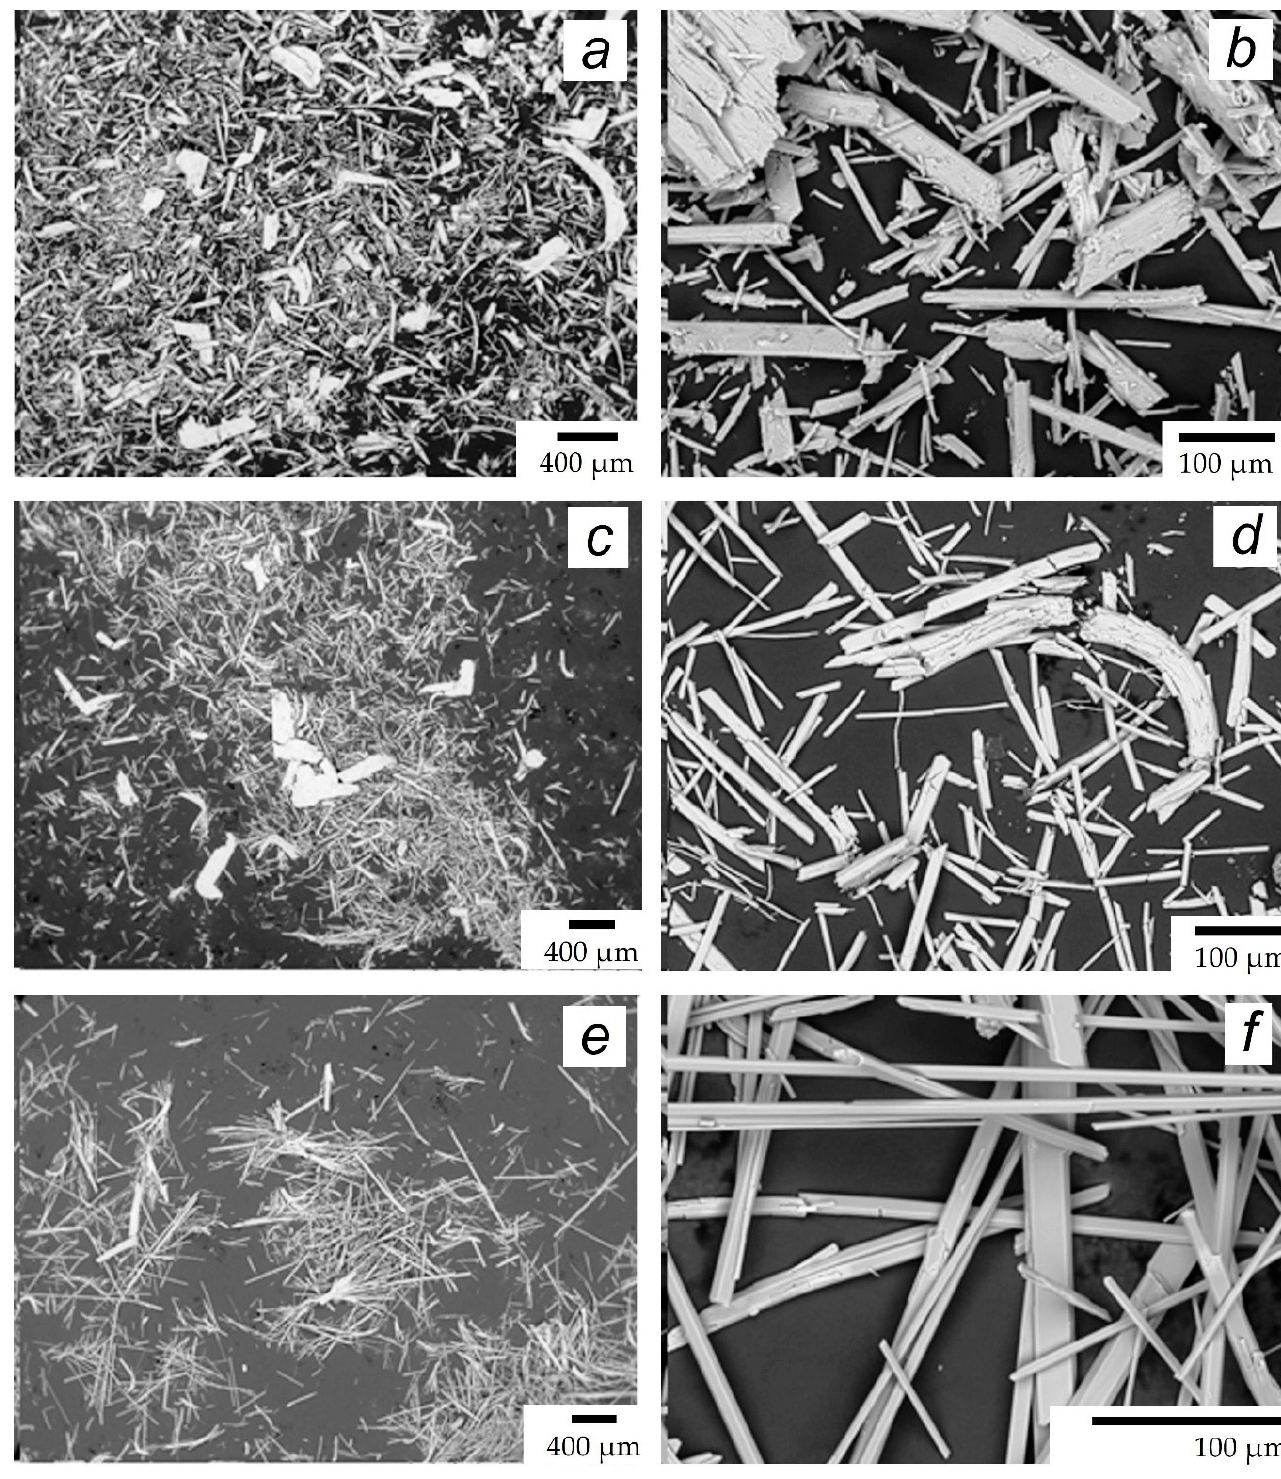
Figure 2. SEM images of calcium sulfate crystals, isolated from I ( a , b ), III ( c , d ), and V ( e , f ) samples from blank